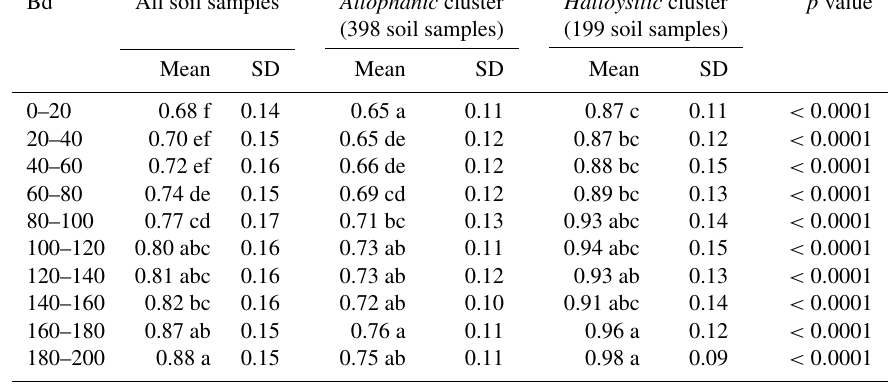
Table 6. Descriptive statistics for bulk densities (Bd in gcm − 3 ) with depth and with their spectral cluster. P value expresses results from the t test between samples from the two cluster classes (Welsh, two-sided alternative). For a given cluster, means followed by the same letters do not differ significantly at p = 0 . 05. Bd All soil samples Allophanic cluster Halloysitic cluster p value (398 soil samples) (199 soil samples)